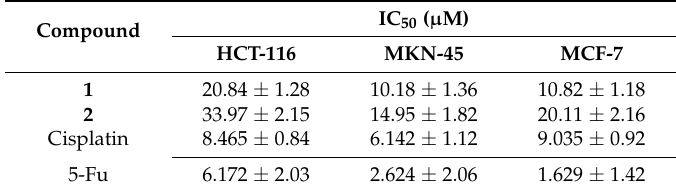
Table 3. Cytotoxicity of compounds 1 and 2 against three human cancer cell